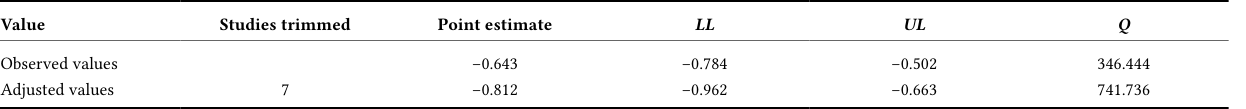
Duval and Tweedie's Trim and Fill